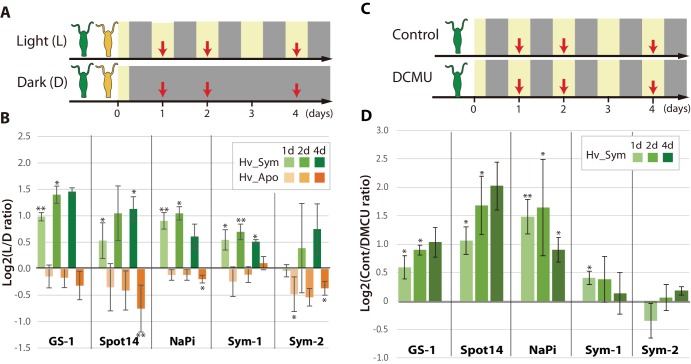
Differential expression of Hydra genes under influence of Chlorella photosynthesis.(A) Sampling scheme. Hv_Sym (green) and Hv_Apo (orange) were cultured under a standard light-dark regime (Light: L) and in continuous darkness (Dark: D), and RNA was extracted from the polyps at the days indicated by red arrows. (B) Expression difference of five A99-specific genes in Hv_Sym (green bars) and Hv_Apo (orange bars) between the light-dark condition and darkness. The vertical axis shows log scale (log2) fold changes of relative expression level in Light over Dark. (C) Sampling scheme of inhibiting photosynthesis. (D) Differential expression of the five A99-specific genes under conditions allowing (Control) or inhibiting photosynthesis (DCMU). The vertical axis shows log scale (log2) fold changes of relative expression level in Control over DCMU treated. T-tests were performed between Light and Dark (B), and DCMU and Control (D). For each biological replicate (n = 3) 50 hydra polyps were used for total RNA extraction. Error bars indicate standard deviation. P-value of t-test, *<0.05, **<0.01.